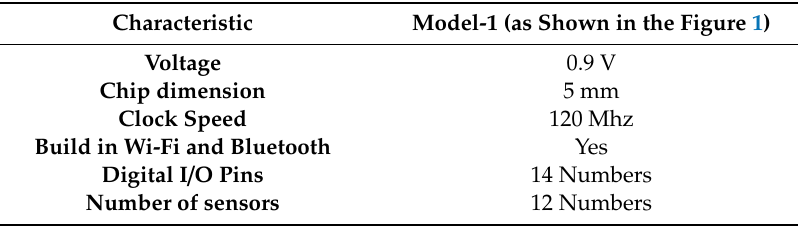
Table 4. Hardware specification of the wearable IoT smart log